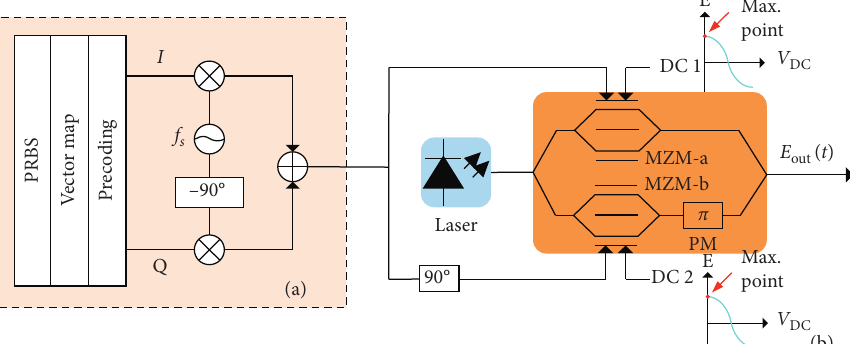
Figure 7: Diagram of photonic vector mm-wave signal generation. (a) Block diagram of offline vector signal generation; PRBS, pseudo random binary sequence. (b) Principle of mm-wave generation of vector signal